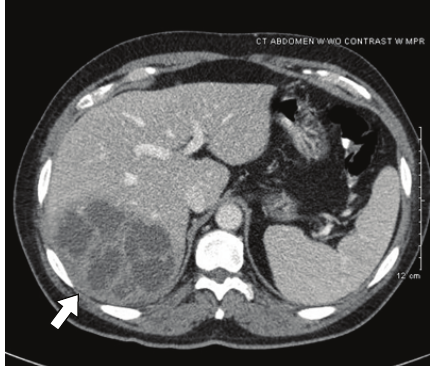
Figure 2: CT venous phase showing large hepatic abscess (arrow).